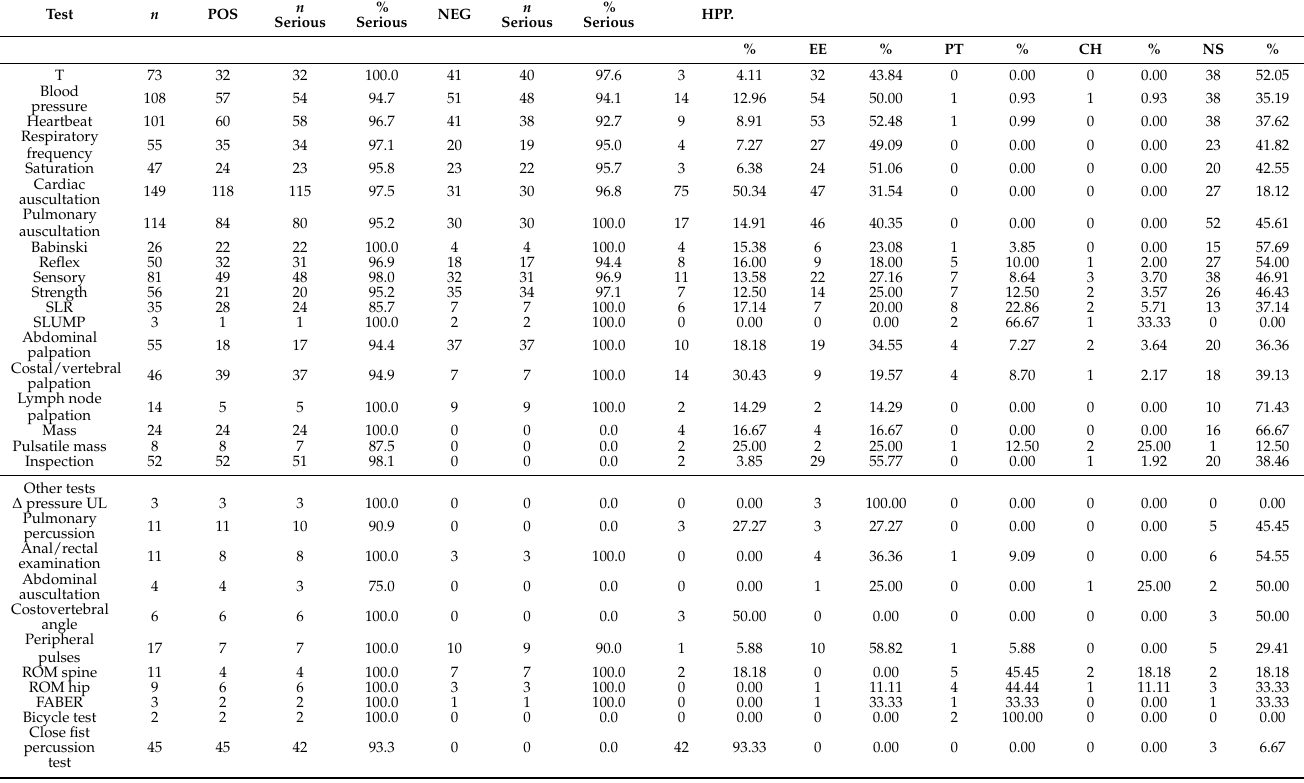
Table 2. Physical examination tests performed by primary healthcare